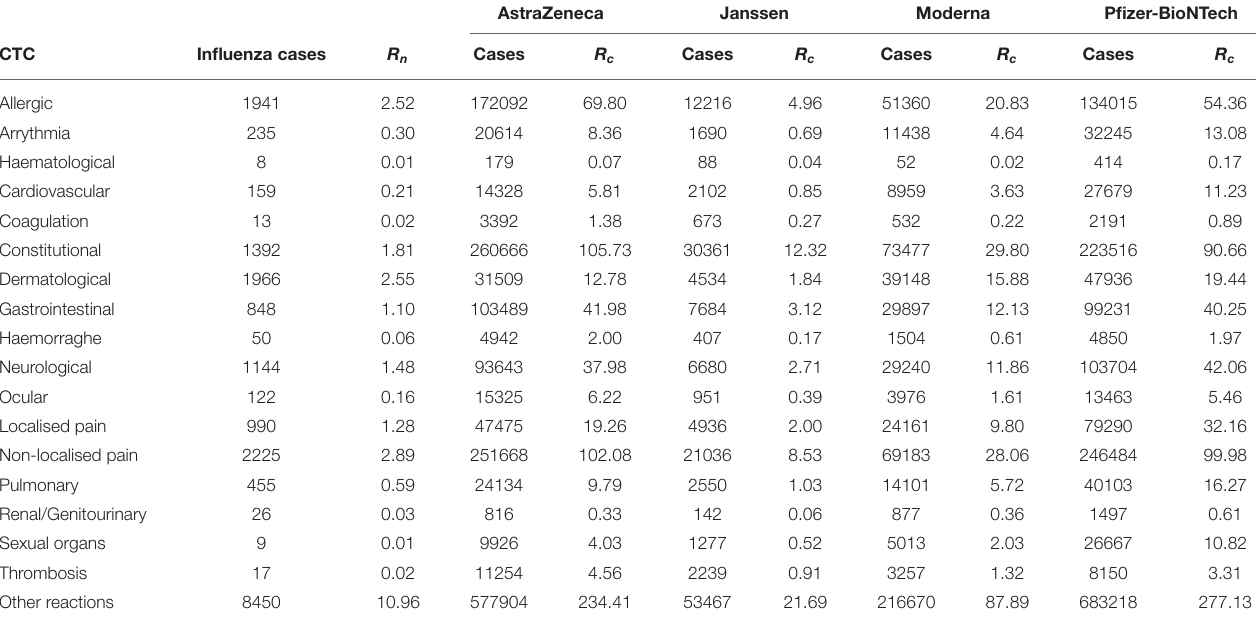
TABLE 2a | Vaccine-related risk estimates of influenza ( R n ) and COVID-19 vaccines ( R c ) per 100,000 exposed individuals by Common Toxicity Criteria (CTC) in the EudraVigilance database.